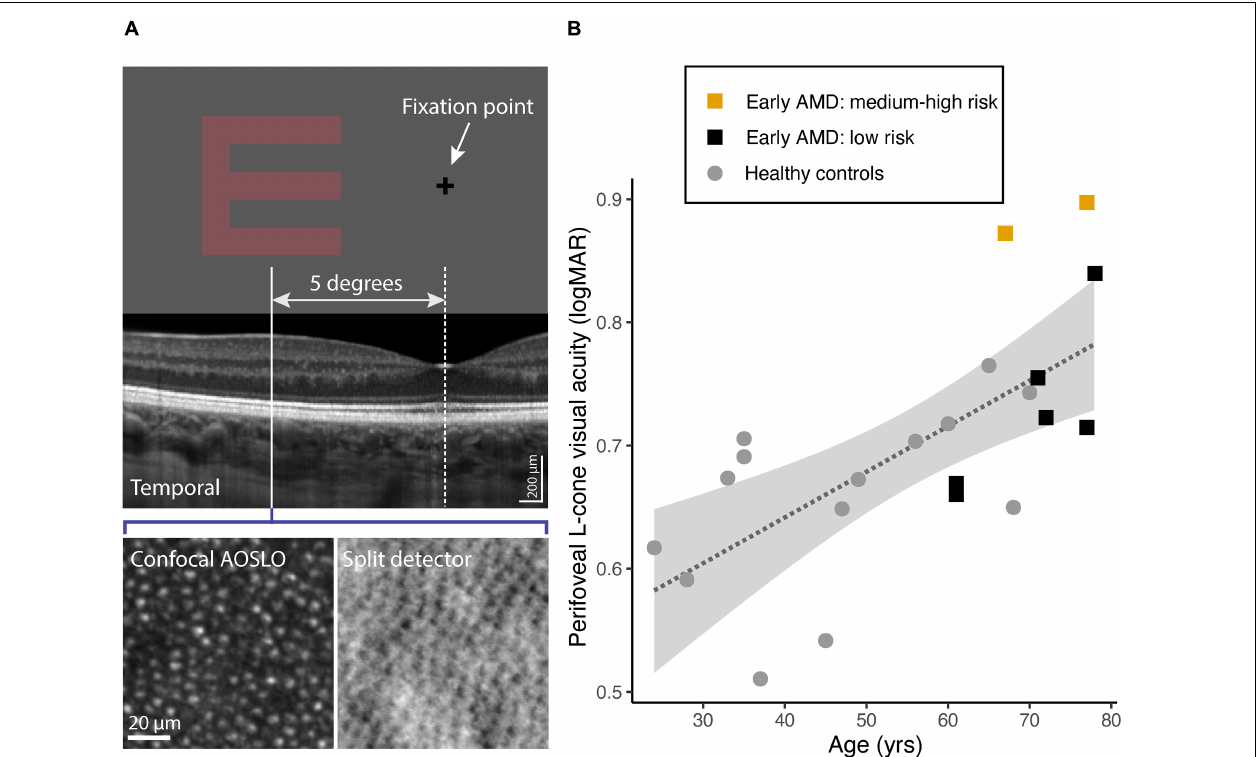
FIGURE 2 | (A) The L-cone isolating Sloan E presented at 5 degree temporal eccentricity. SD-OCT, confocal and spit-detection AOSLO images were analyzed at the corresponding retinal location. (B) L-cone logMAR as a function of age: 14 healthy controls (gray filled circles) and 8 participants with early AMD: 6 with low risk of progression (black filled squares) and 2 with medium or high risk of progression (orange filled squares). The dashed line shows the best-fit linear regression to the data. The gray shaded area indicates the 95% confidence intervals for the fitted regression